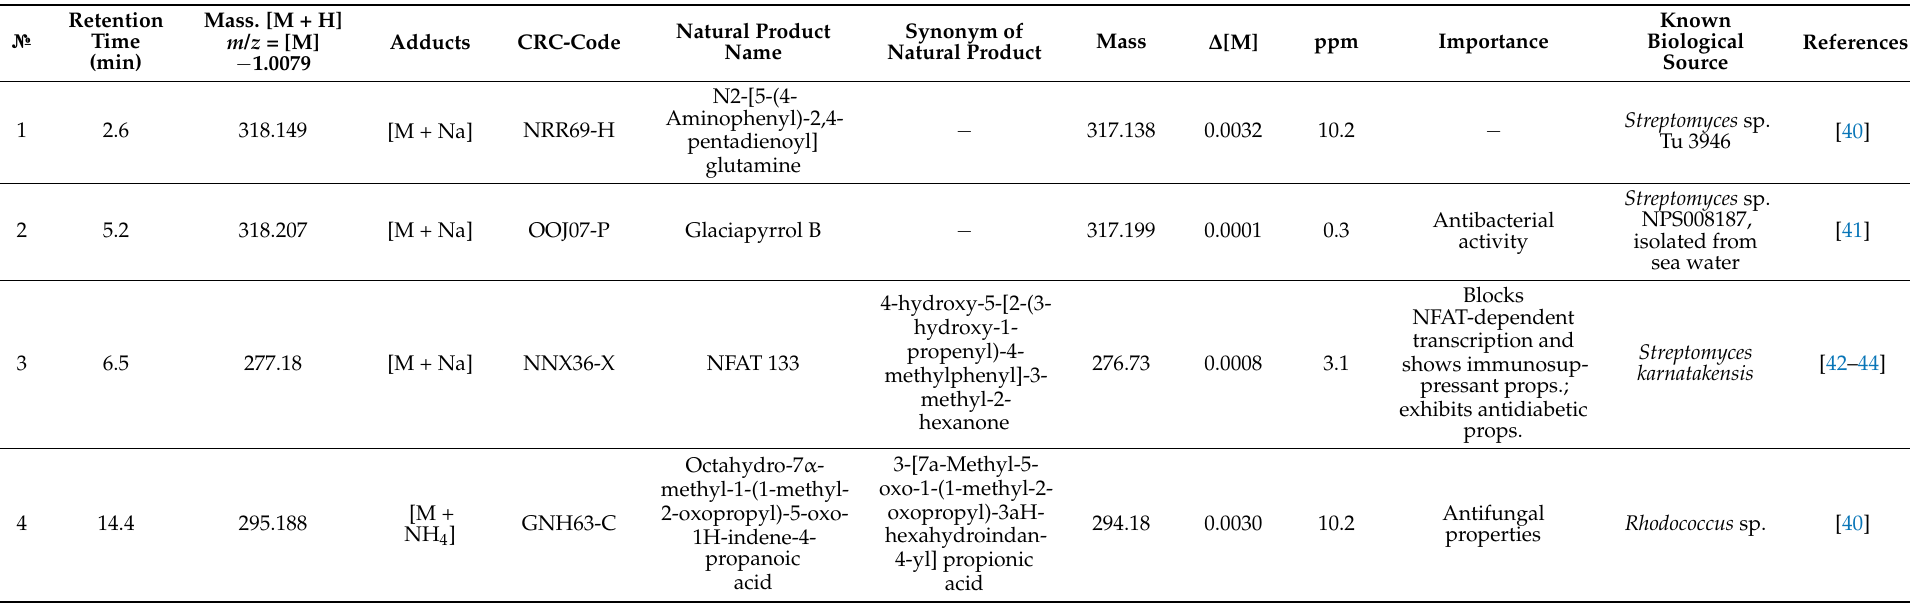
Table 3. Pre-identified natural products of Streptomyces sp. LPB2019K190-4 and Rhodococcus sp. LPB2019K201-3 cultivated on nutrient medium with sawdust